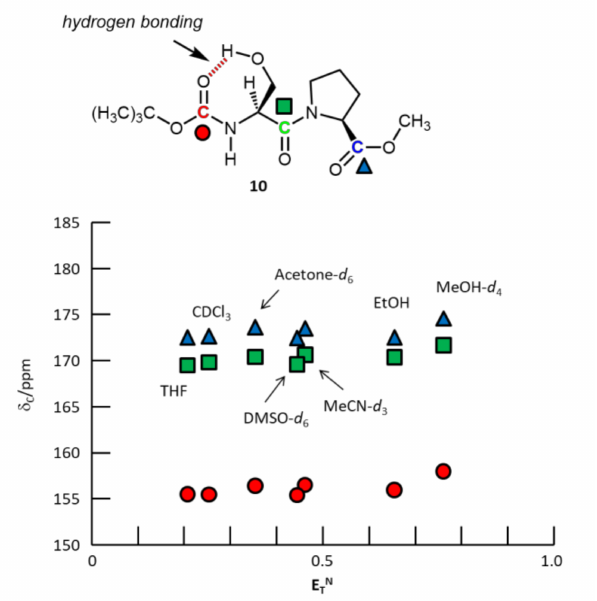
Figure 13. 13 C NMR chemical shifts of the carbonyl carbons of N -Boc-L-serine-L-proline-OMe 10